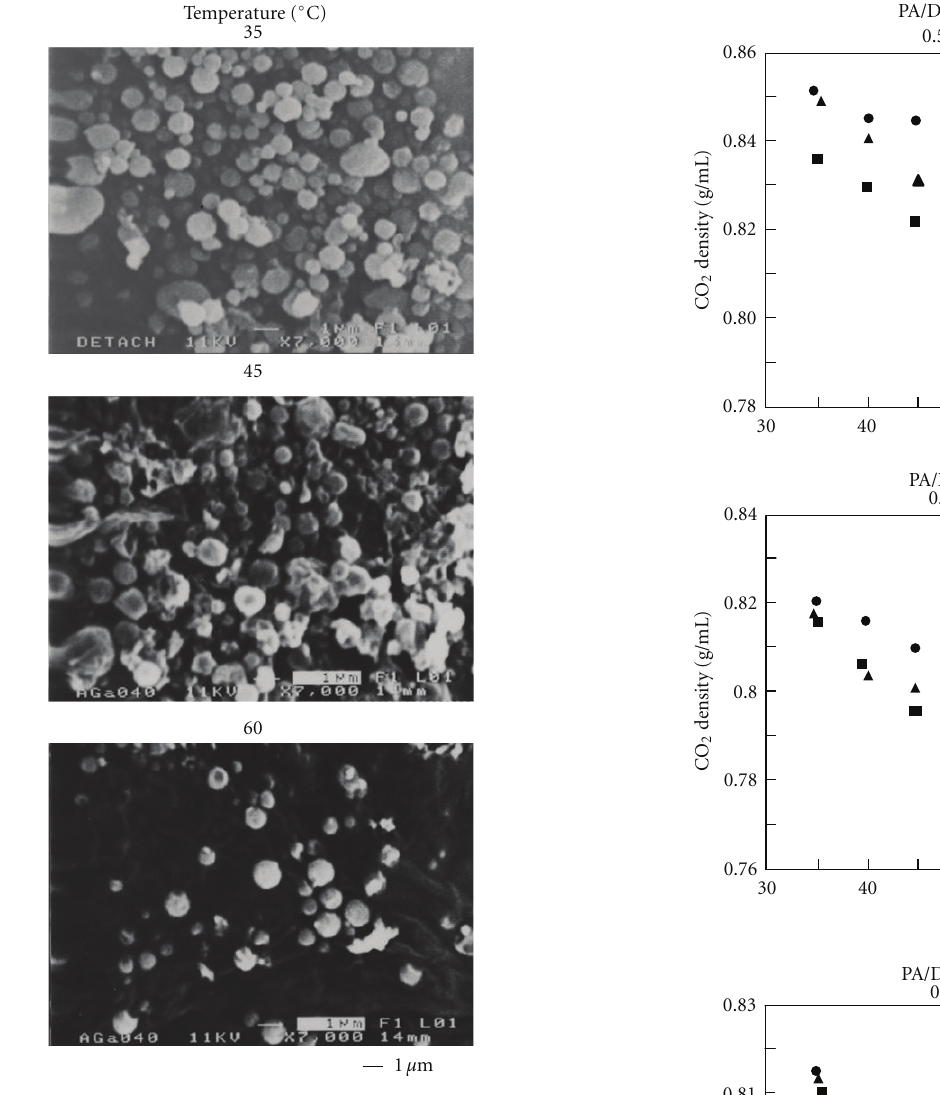
Figure 13: SEM images of the polymer particles obtained at 35, 45, and 60 ◦ C. PA/DAA = 0.5.